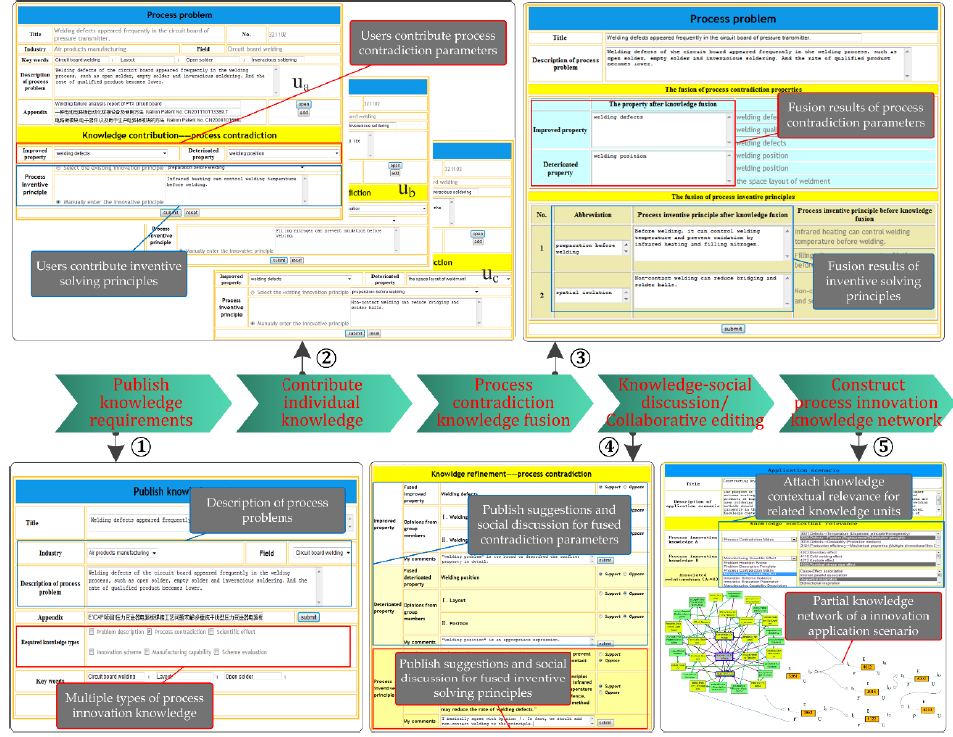
Figure 6. An instance of welding process innovation knowledge capture process. Part 1: Publish knowledge requirements; Part 2: Contribute individual knowledge; Part 3: Process contradiction knowledge fusion; Part 4: Knowledge-social discussion/Collaborative editing; Part 5: Construct process innovation knowledge network.